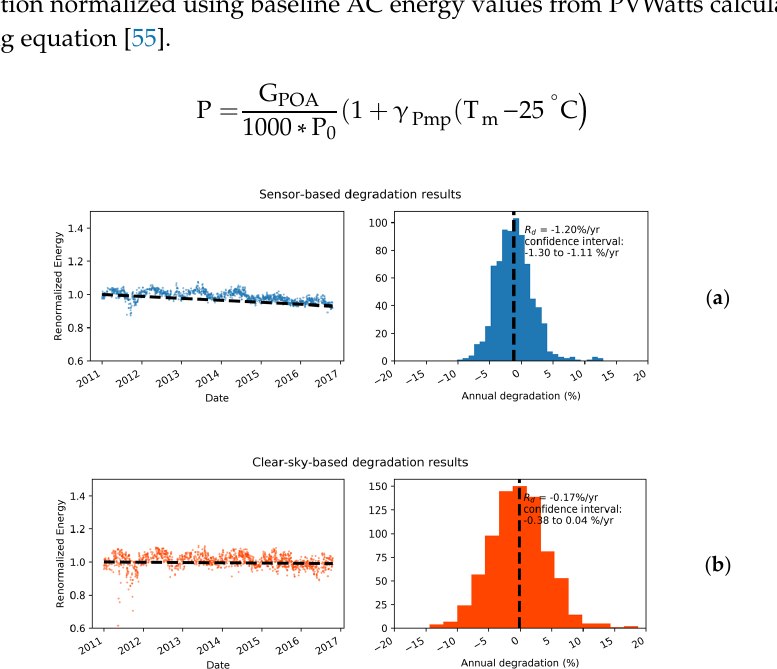
Figure 4. Examples of the degradation rate of a copper indium gallium selenide (CIGS) PV system from Site 27 in Alice Springs. The degradation calculation based on ( a ) measurement sensors, and ( b ) a clear sky model.